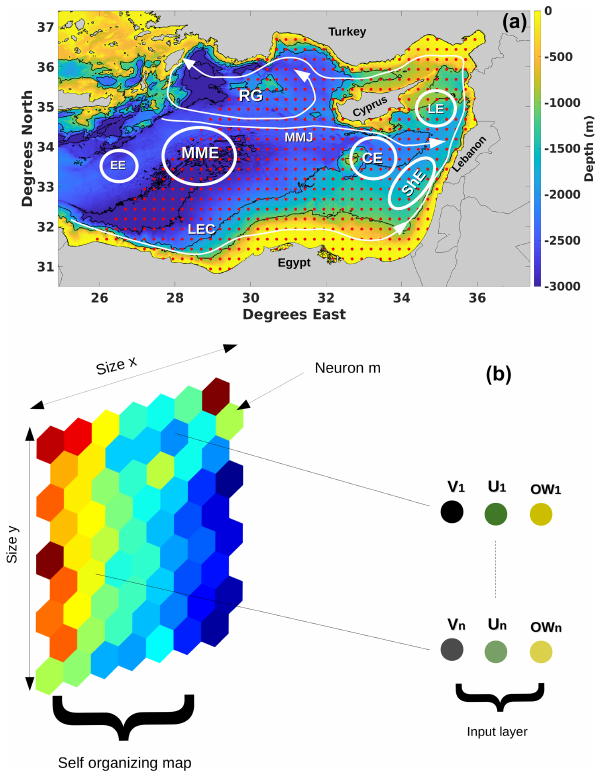
Figure 1. (a) A schematic representation of the main structures present in the Levantine basin (RG: Rhodes Gyre; LE: Lattakia Eddy; EE: Egyptian Eddy; LEC: Libyo-Egyptian Current; MMJ: Mid-Mediterranean Jet; MME: Mersa Matruh Eddy (also known as Herodotus Trough eddies); CE: Cyprus Eddy; ShE: Shikmona Eddy; LE: Lattakia Eddy). All elements are placed in the context of a bathymetry map. The red dots represent the coordinates of the grids providing the input data for the SOM. Each red dot ( n ) is com- posed of U and V components and the Okubo–Weiss (OW) param- eter. (b) A schematic representation of the SOM method: the input layer obtained from the input data and the adaptation layer com- posed of n neurons automatically associated in an orderly fashion. Each neuron represents a set of U , V , and OW that represents sim-